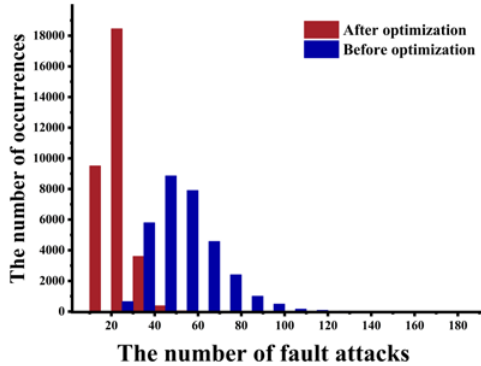
Figure 11. The relationship between the remaining information content and the number of intersections.